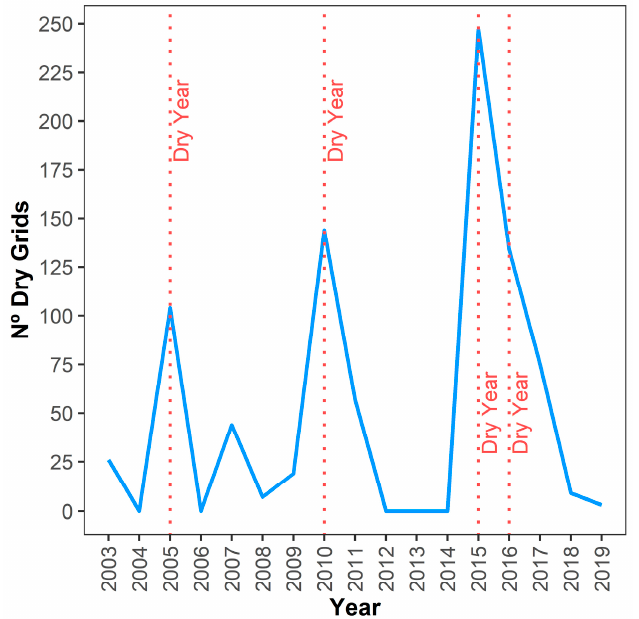
Figure A3. Number of dry grid cells per year. The years that were considered as severe droughts are highlighted in